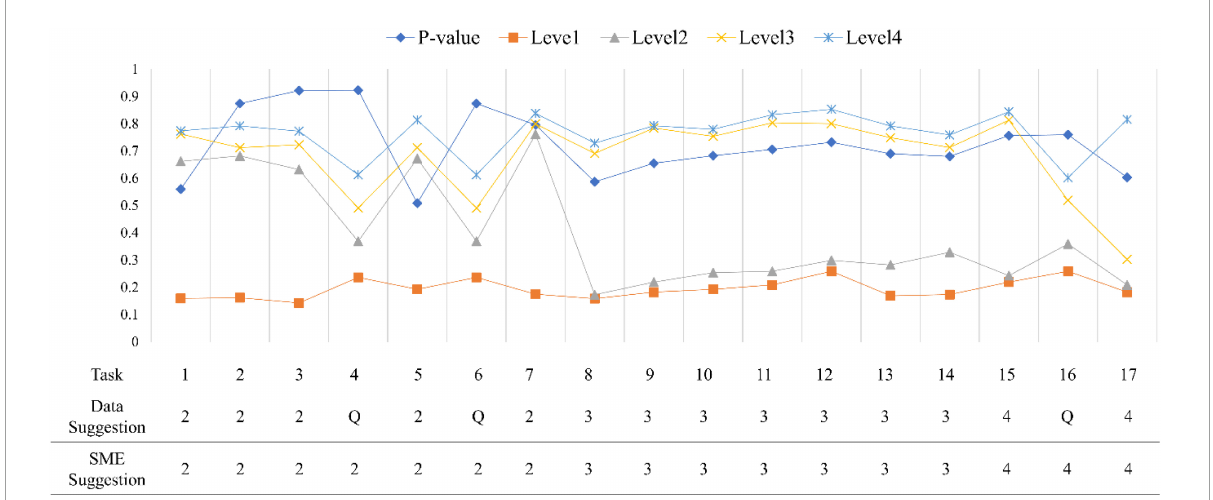
FIGURE7 Conditional probabilities for all items at the first occasion. P -value indicates a proportion of correcting a task; SME is a subject matter expert group; Q indicates an ambiguous